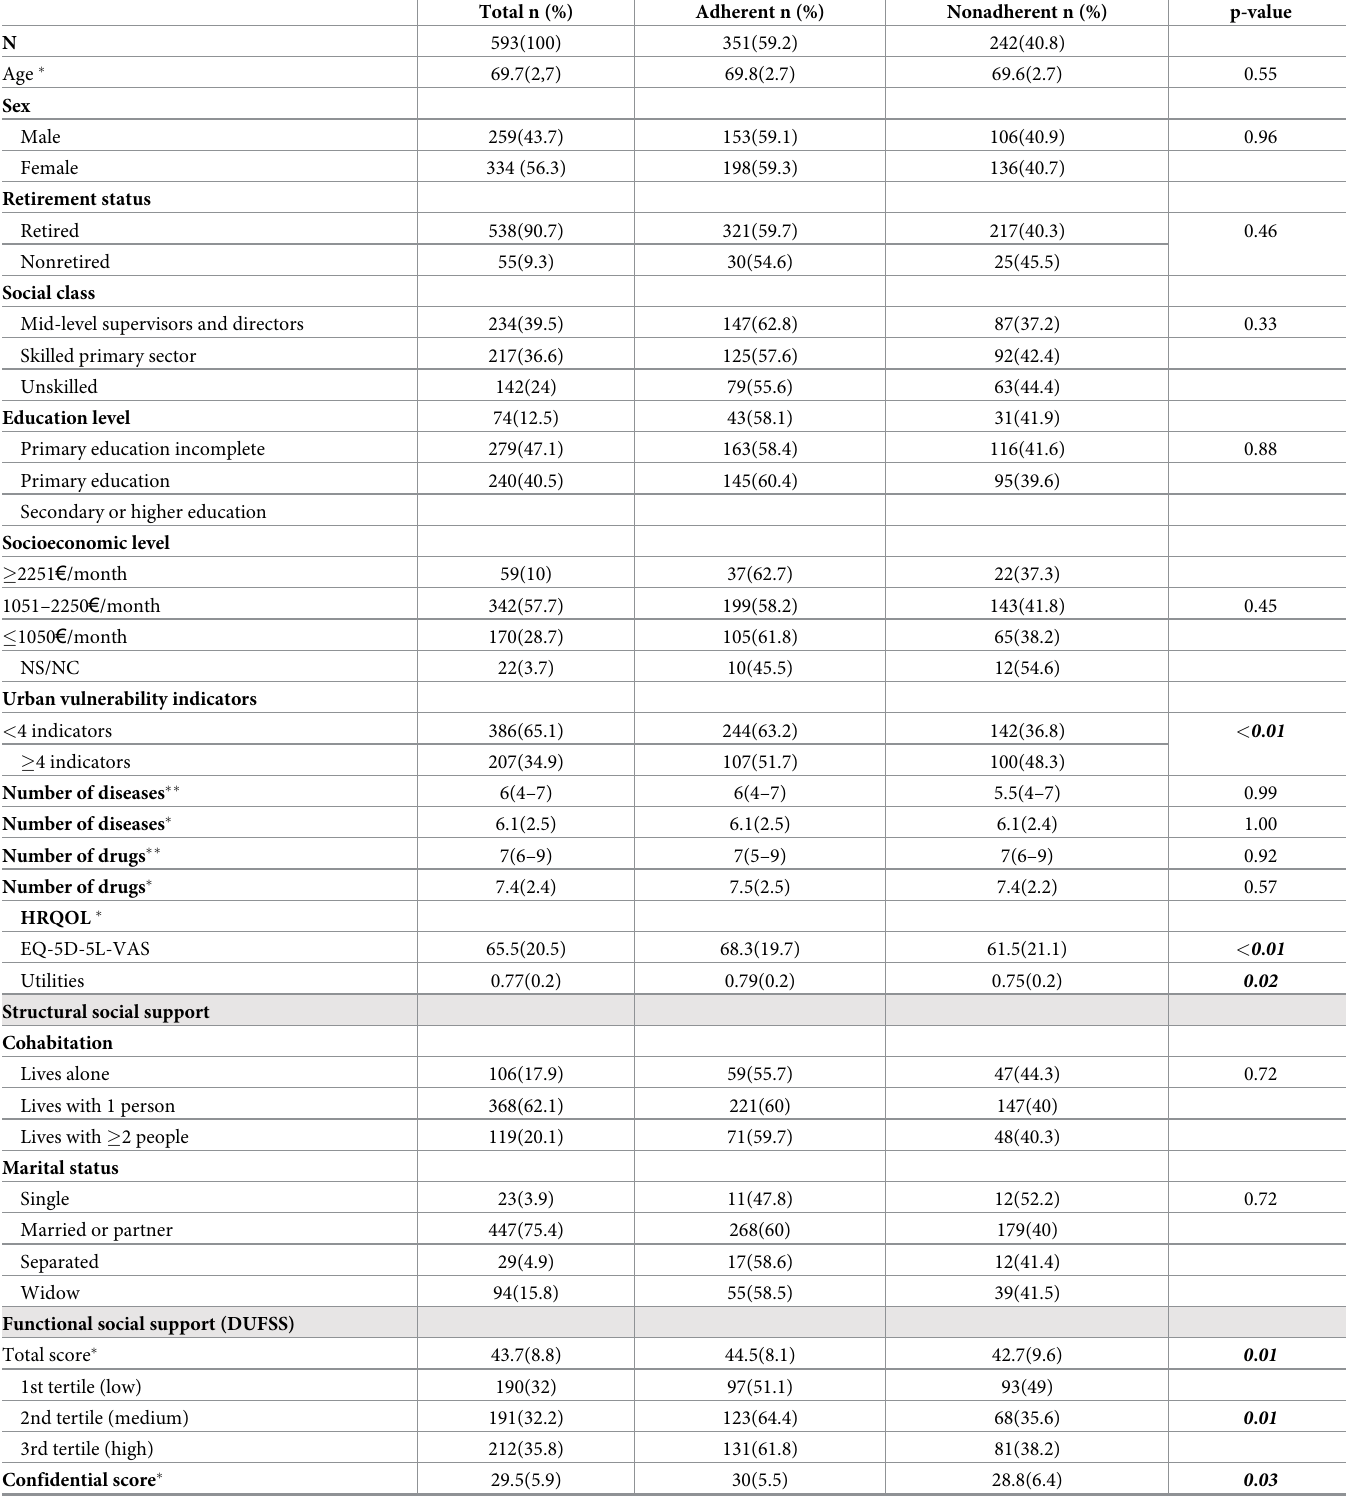
Table 1. Characteristics of patients according to